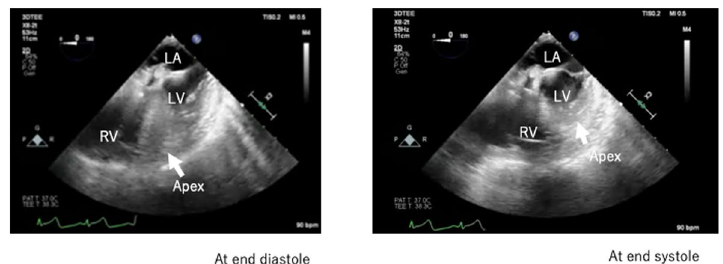
Fig. 1 Four-chamber mid-esophageal echocardiographic images at end diastole (left) and end systole (right). The left ventricular apex shifted significantly during the cardiac